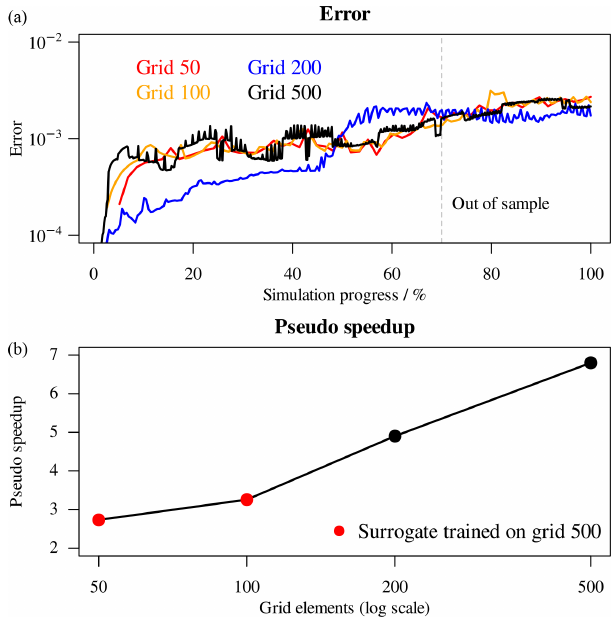
Figure 14. (a) Errors of surrogate simulations with respect to refer- ences. (b) Overall pseudo-speedup after